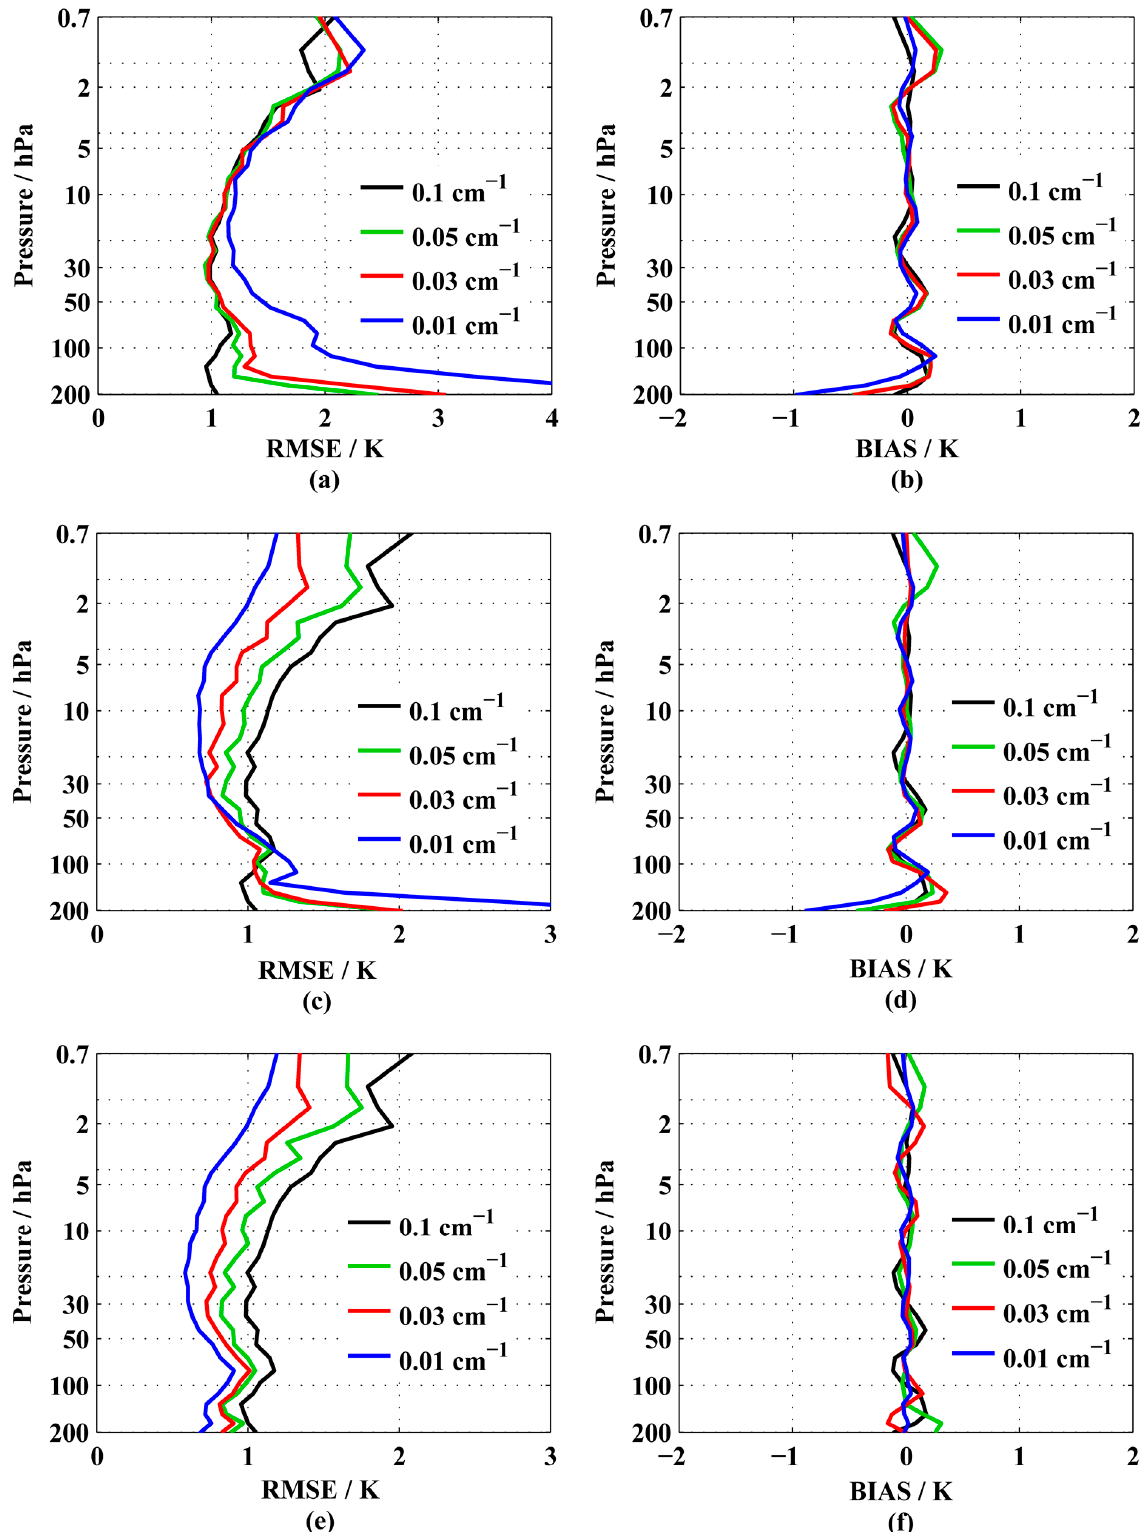
Figure 13. The temperature retrieval results. ( a , b ) are the results of the single narrow band with di ff erent spectral resolutions when the exposure time and other parameters remain unchanged. ( c , d ) are the results of the single narrow band with di ff erent spectral resolutions when the exposure time is adjusted to keep instrumental noise at 0.1 K. ( e , f ) are the results of multiple narrow bands with di ff erent spectral resolutions.